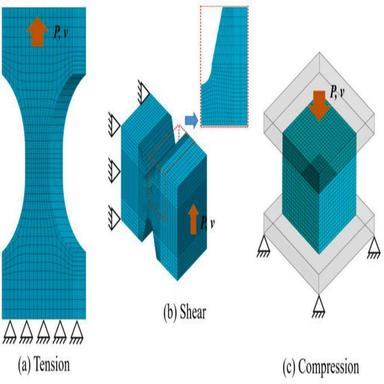
The finite element (FE) mesh, loading and constraint conditions of PMI foam with density of 0.075 g/cm3 under (a) tensile, (b) shearing and (c) compressive loading conditions.